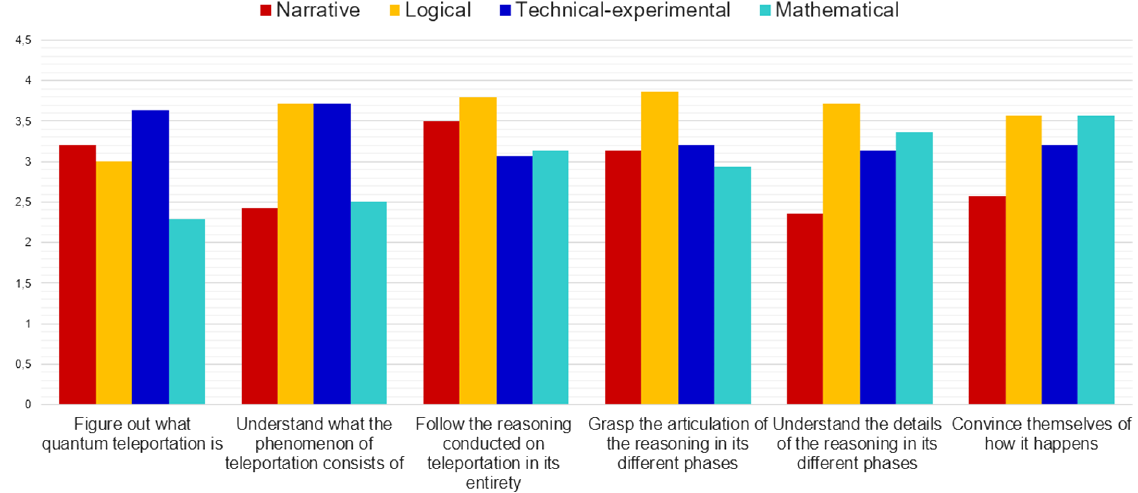
FIG. 20. For the four levels, average of the score attributed to each aspect (range: 0 – 5).